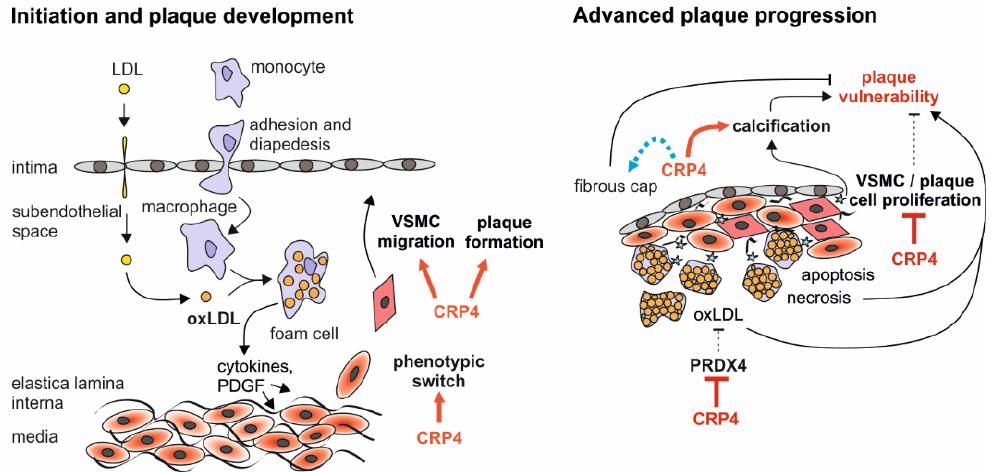
Figure 6. Synopsis of the putative functions attributed to CRP4 in atherosclerotic plaque initiation and progression. Proatherogenic CRP4 enhances plaque building by promoting the phenotypic switch and migratory properties of VSMCs. This results in a higher amount of α -SMA expression in the lesion area and an overall higher plaque burden. In advanced plaques, CRP4 may predominantly affect plaque stability through inhibition of the antioxidant enzyme PRDX4. Lower PRDX4 abundance in CRP4 proficient VSMCs and vessels causes a higher level of lesion oxLDL, and this is associated with an enhanced calcification. Vice versa , the anti-proliferative effects of CRP4 on VSMC/plaque cell proliferation may promote a vulnerable state of atherosclerotic plaques. However, the NC of ApoE − / − /CRP4 +/+ lesions are smaller. Since no threshold above which a plaque becomes unstable has been determined, the significance of the latter finding remains unclear.